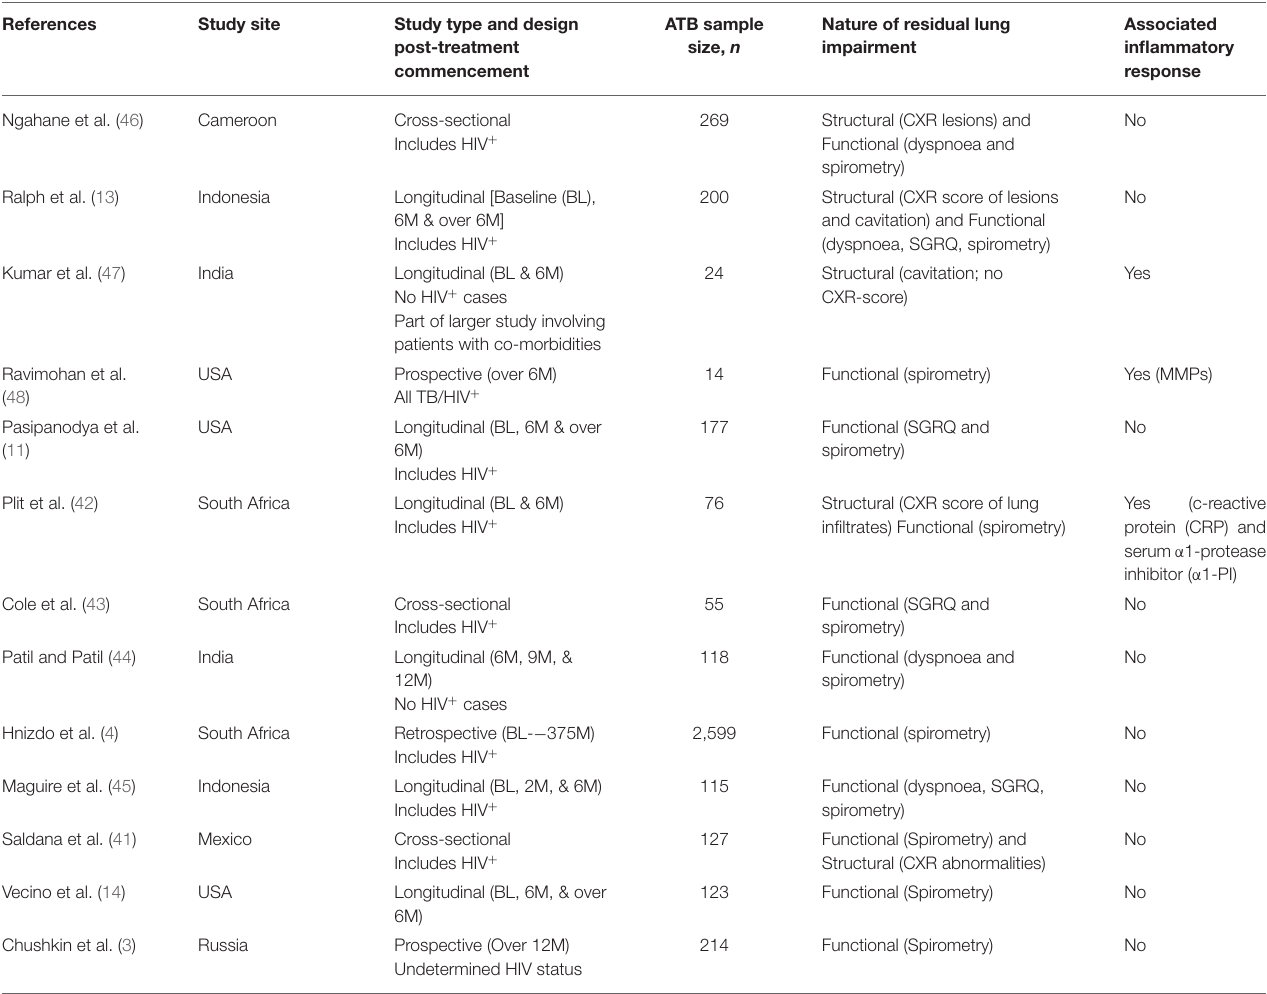
TABLE 1 | Clinical studies assessing TB